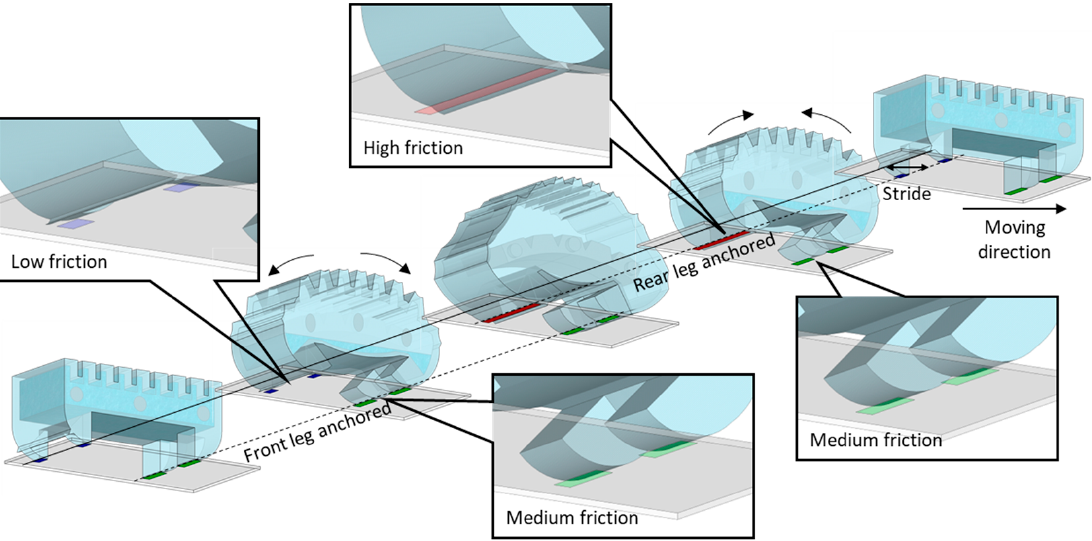
Figure 2. Moving mechanism of WIBot using friction hysteresis. When legs have tangential lengths of 1200, 2500, and 3500 μ m, the substrate areas where the leg touches are marked blue, green, and red, respectively. The magnitude of the frictional force increases as the tangential length of the leg increases.